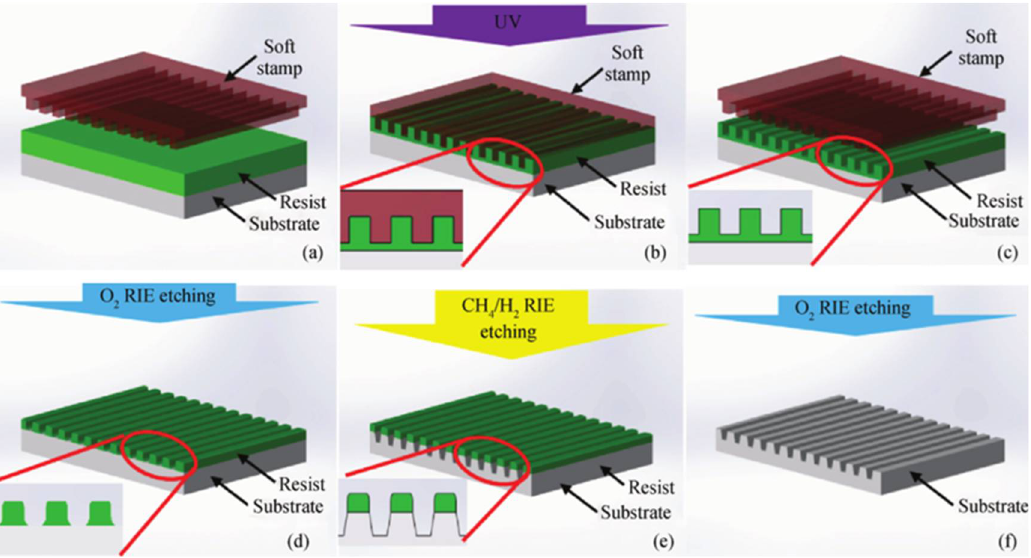
Figure 5. Preparation of gratings by UV soft printing ( a – c ) transfer the patterns onto the epitaxial structure ( d ) clean residual resist ( e ) fabricate grating ( f ) remove the mask [42]. © IOP Publishing. Copyright 2014 Journal of